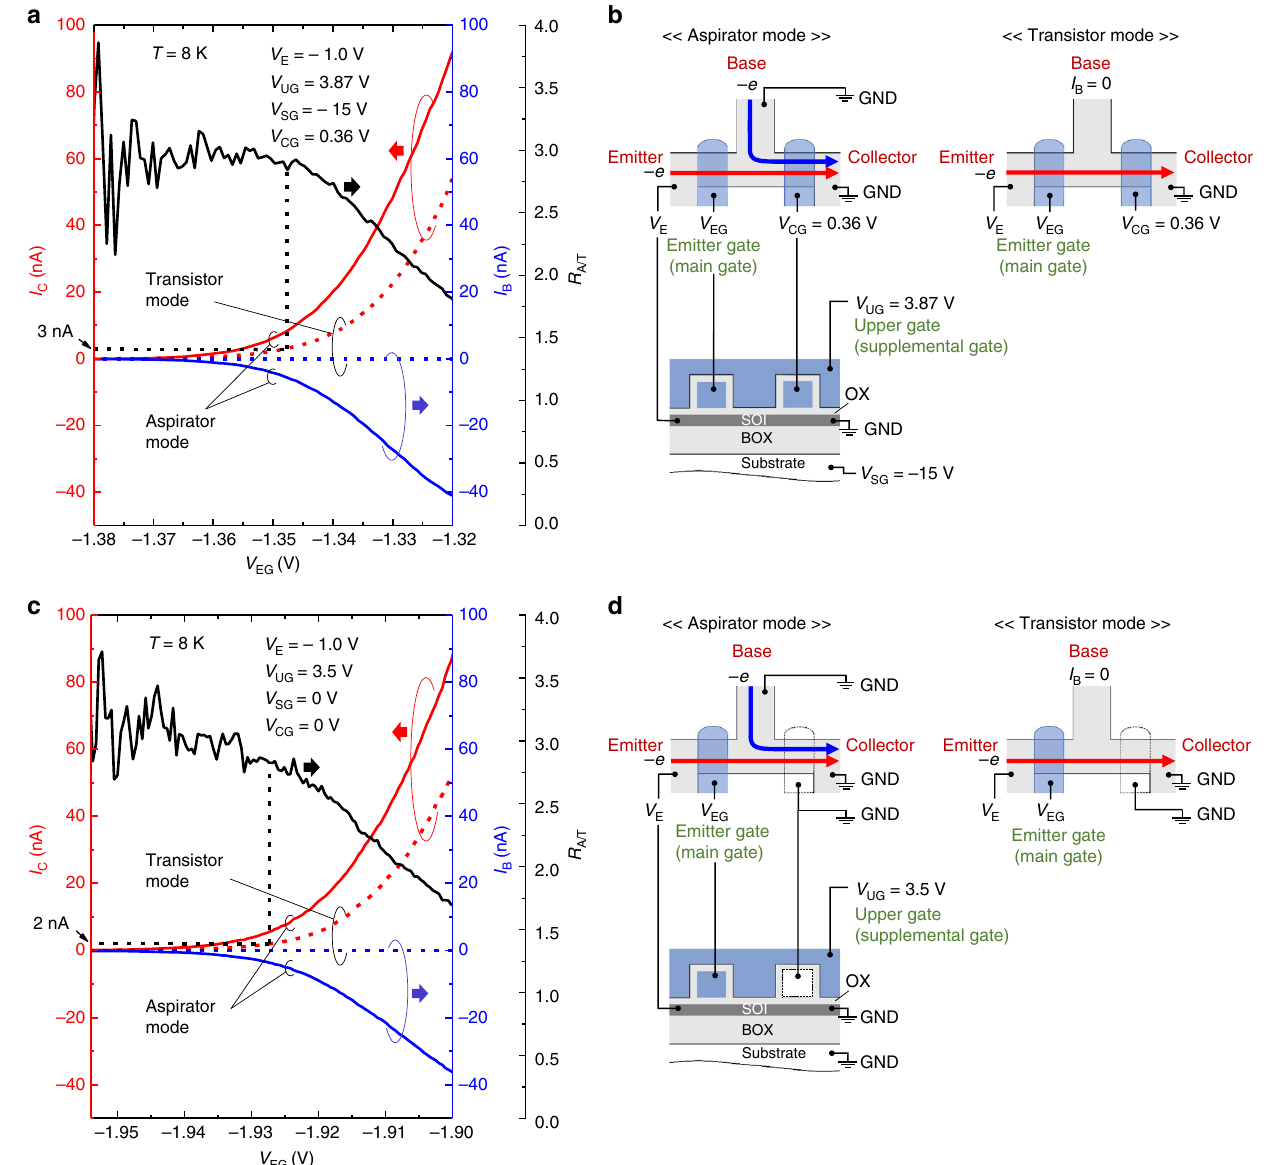
Fig. 5 Comparison between the transistor-mode and aspirator-mode characteristics. The collector current I C and the base current I B as a function of the emitter gate voltage V EG . The solid and dotted lines show the current curves in the aspirator-mode and transistor-mode, respectively. The collector (corresponding to the drain of the transistor) and the base currents are shown in red and blue, respectively. The R A/T is shown in black. The measurement setup for the aspirator- and transistor-modes are also shown. The arrows show the direction of the electron fl ow. a Measurement data with the collector and the substrate (back) gates being biased at V CG = 0.36 V and V SG = − 15 V. b Voltage setup for data shown in a . c Measurement data with the collector and the substrate gates being grounded. d Voltage setup for data shown in